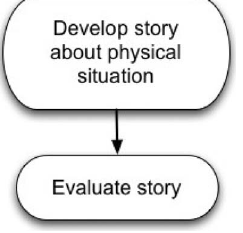
FIG. 3. Schematic diagram of some moves in the epistemic game Physical Mechanism.